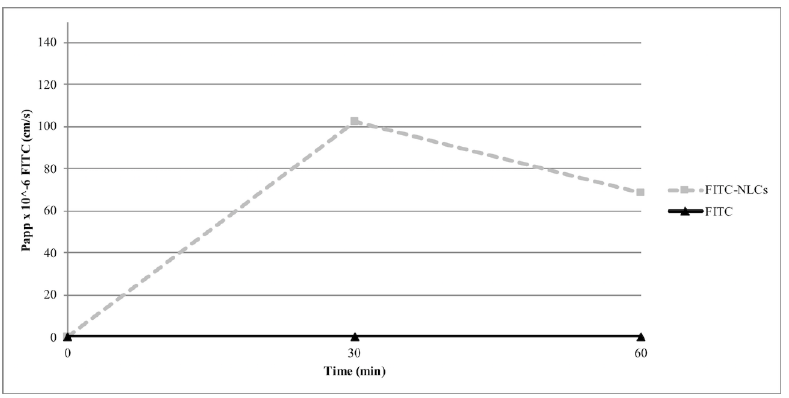
Figure 4. Apparent permeability coefficient ( P app ) of free FITC or loaded into NLCs (FITC-NLCs) across the Caco-2 monolayer after 1 h of incubation.